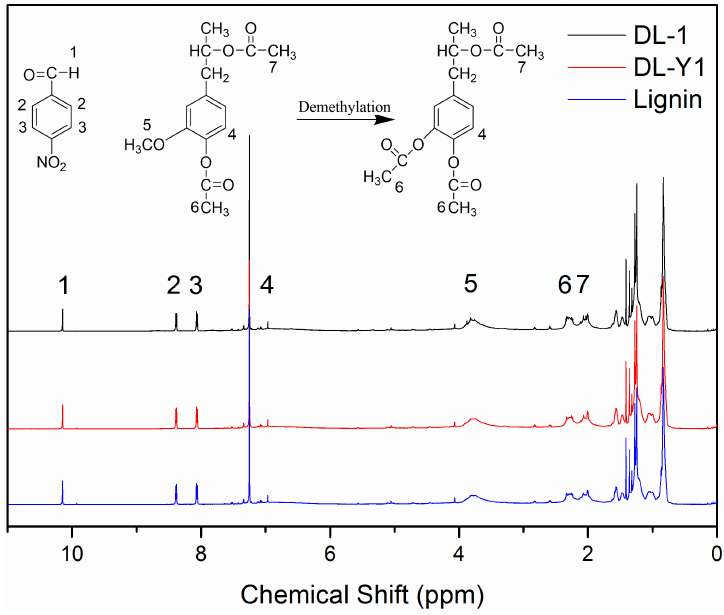
Figure 1. 1 H-NMR (nuclear magnetic resonance) spectra of lignin, DL-1 and DL-Y1.